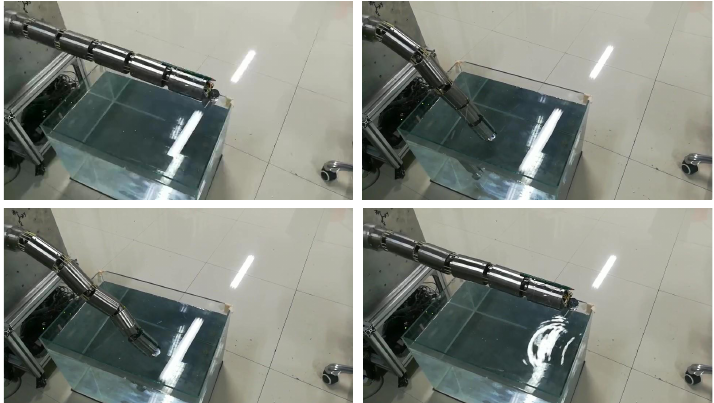
Figure 13. Experiment of SET2 in the underwater